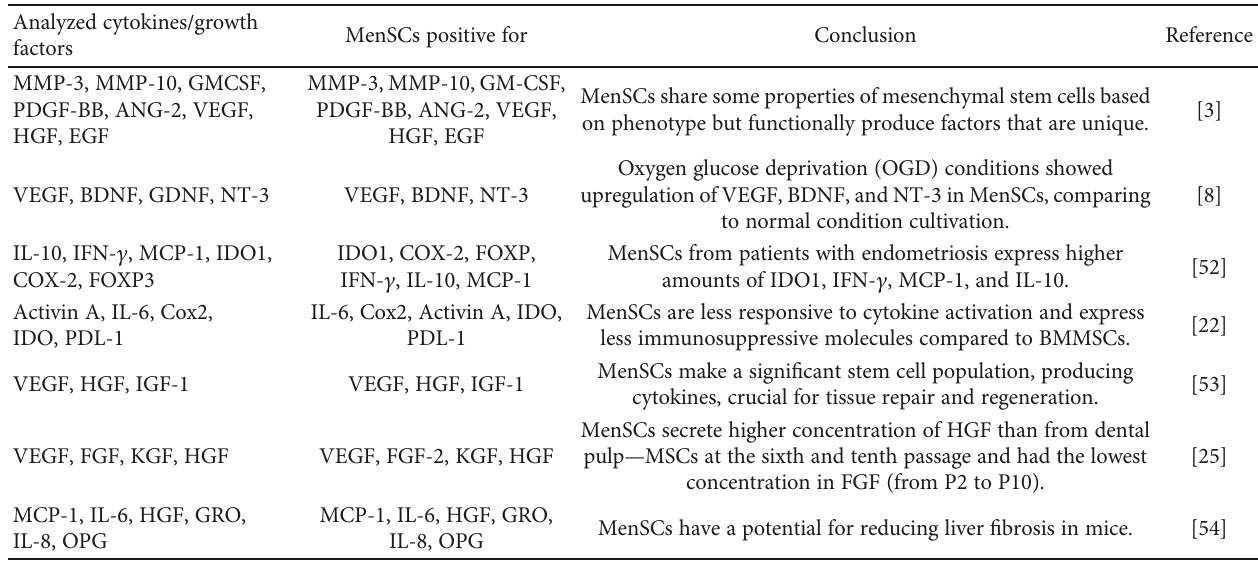
Table 1: The analysis of MenSC secretome in published studies ∗